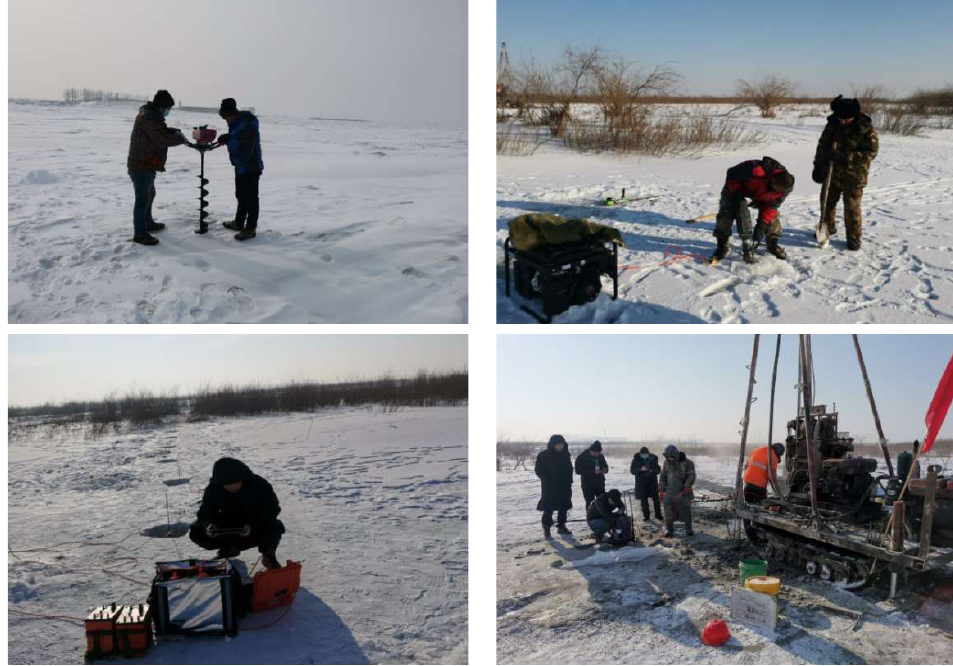
Figure 4. The multi-electrode resistivity method test and shear wave velocity test in the field.